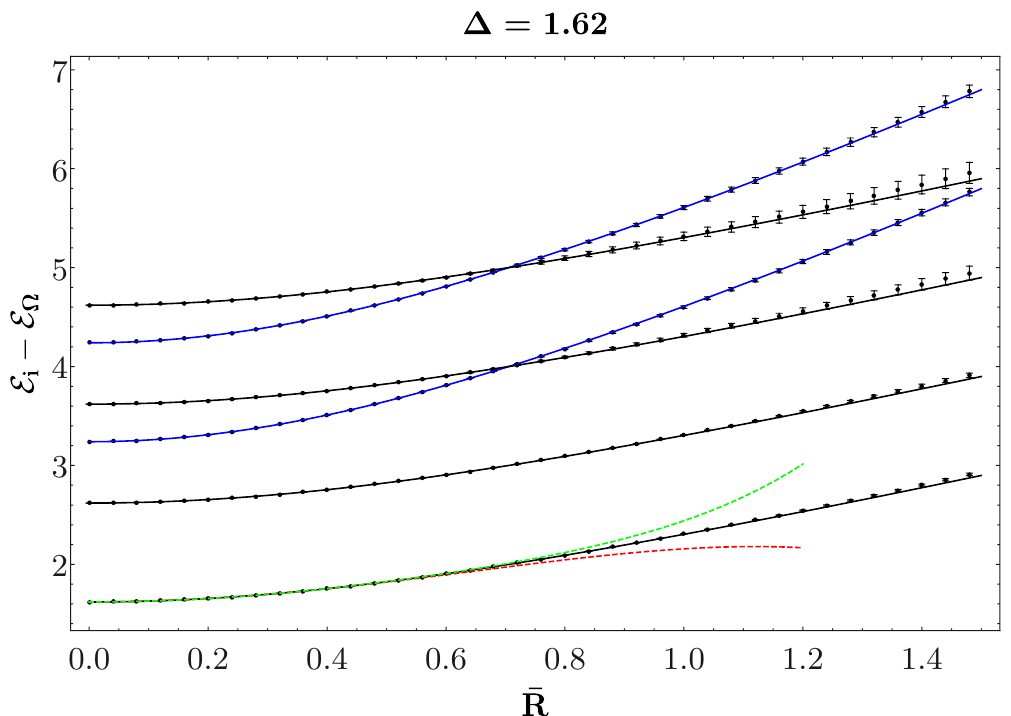
Figure 11. Spectrum of the first six excited energies in the φ 2 theory with ∆ = 1 . 62 . Dots with error bars: Hamiltonian truncation data. Black and blue solid curves represent the exact spectrum; the red and green dashed lines are exact results for the first level, truncated to second resp. third order in perturbation theory. The black curves are the one-particle state | χ i and its first three descendants; the blue curves are the two-particle state ( a † ) 2 | Ω i and its first 0